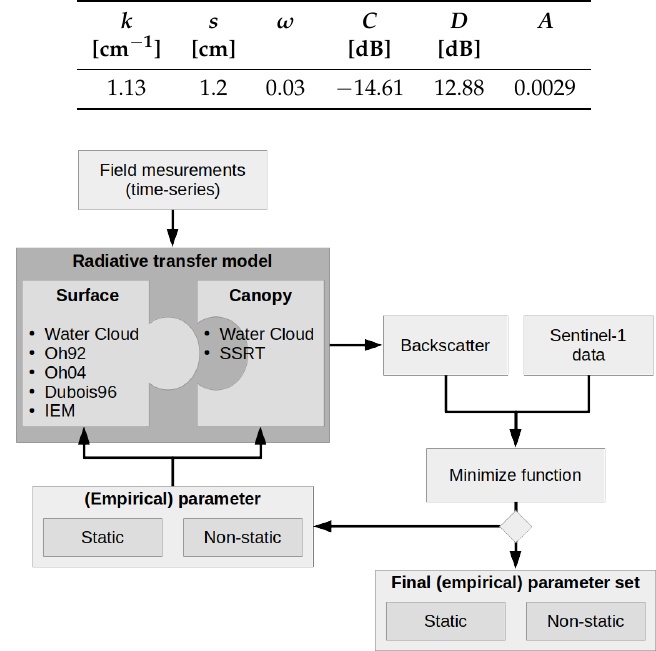
Table 5. Used model input parameters for validation.